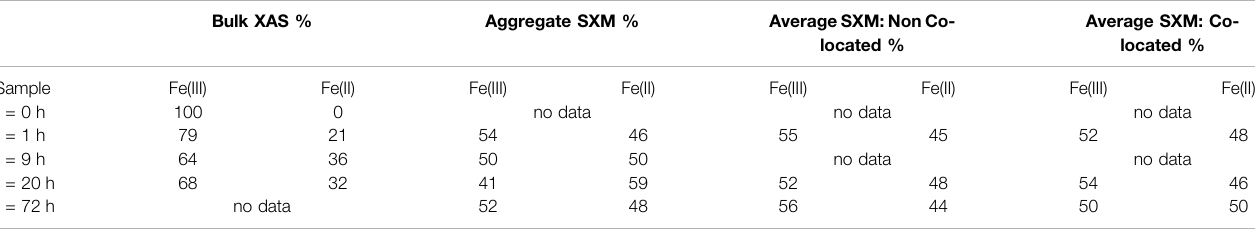
TABLE 3 | Summary ofFe species proportions from keytime points according to best fi ts using octahedral metal calculation for bulk L 2,3 - edge data and average SXM data points. Aggregate SXM, spectra of the entire area imaged and analysed.